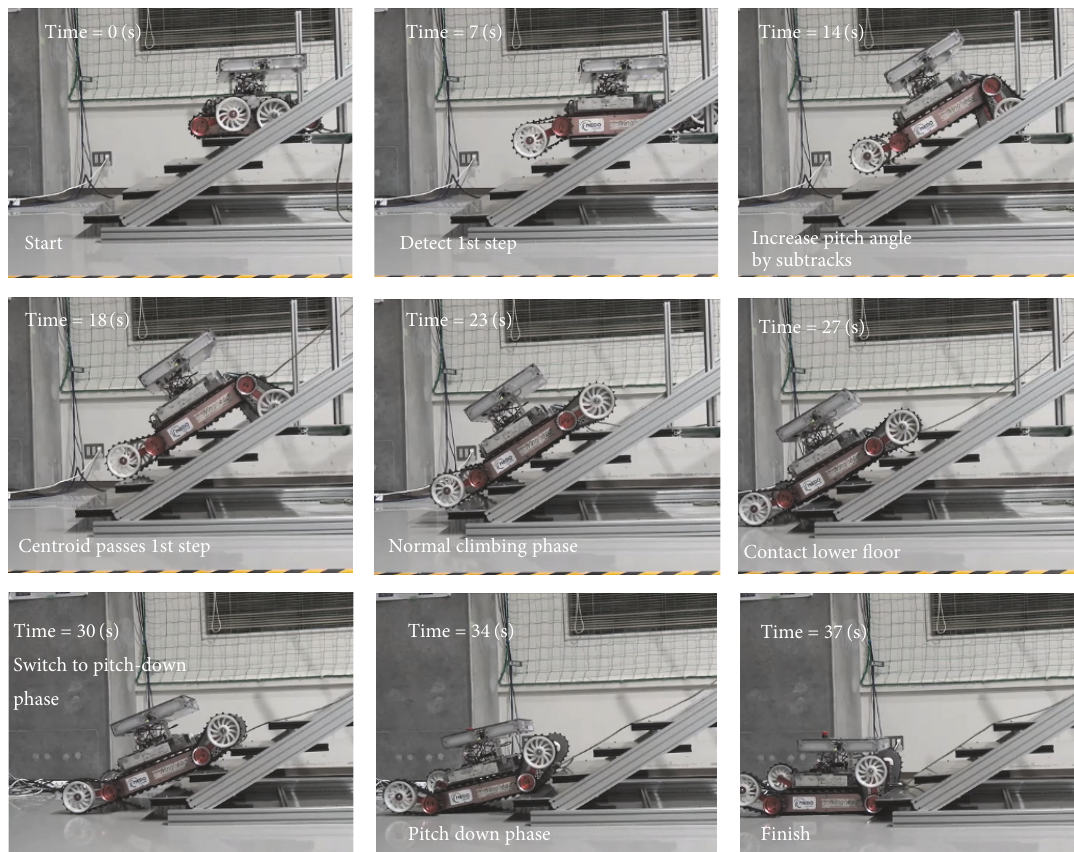
Figure 21: Climbing-down behavior for case 𝜃 𝑠 = 30 ∘ , 𝑝 = 200 mm.